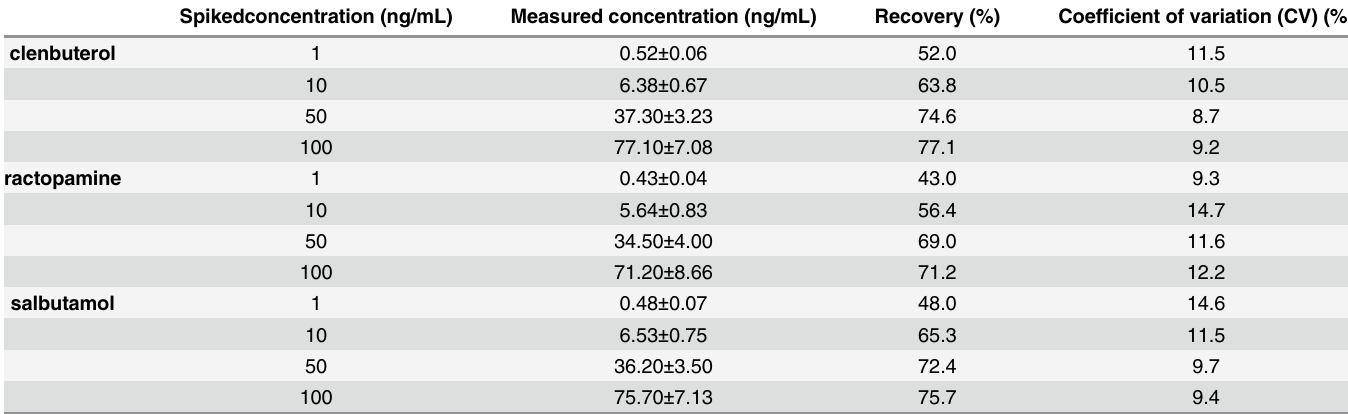
Results are mean ± SD (n =